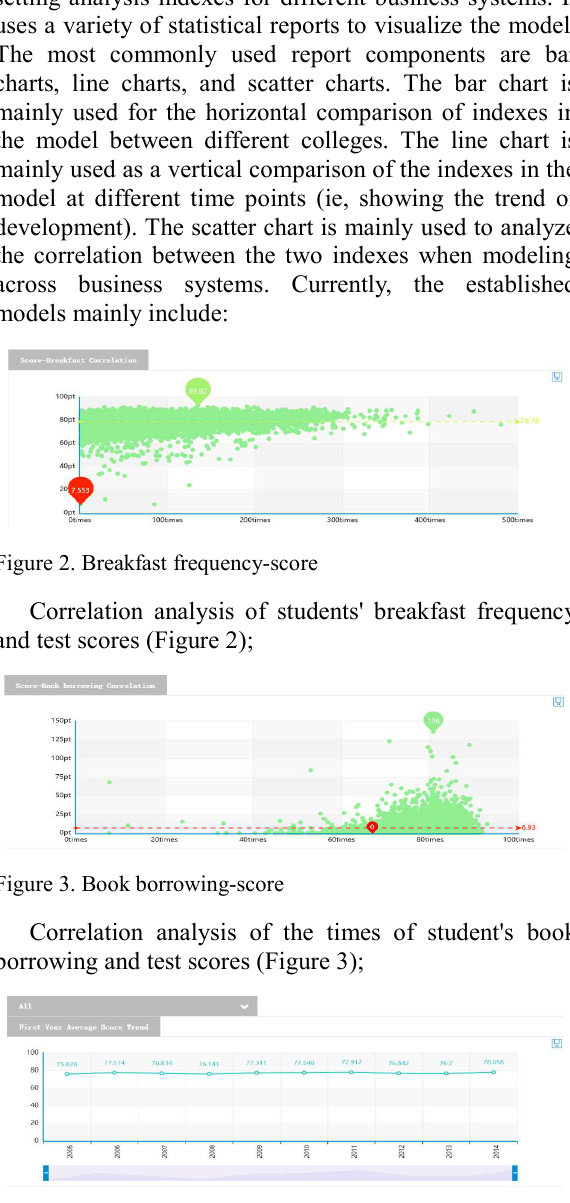
Figure 4. Freshmen average score trend